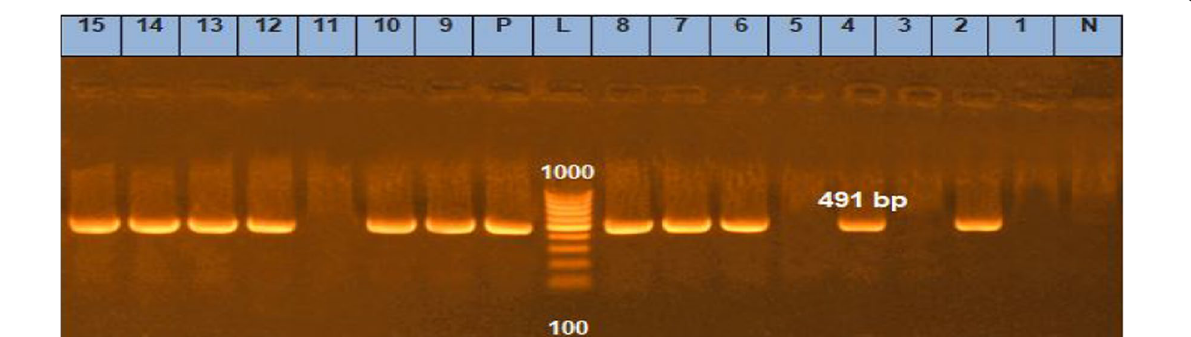
Fig. 11 Agarose gel electrophoresis showing amplification product of 491 bp of qnrS . Lane L : Ladder (Marker) 100‑1000 bp plus DNA ladder. Lane P : control positive. Lane N : control negative. Lane 1–15 : examined isolates